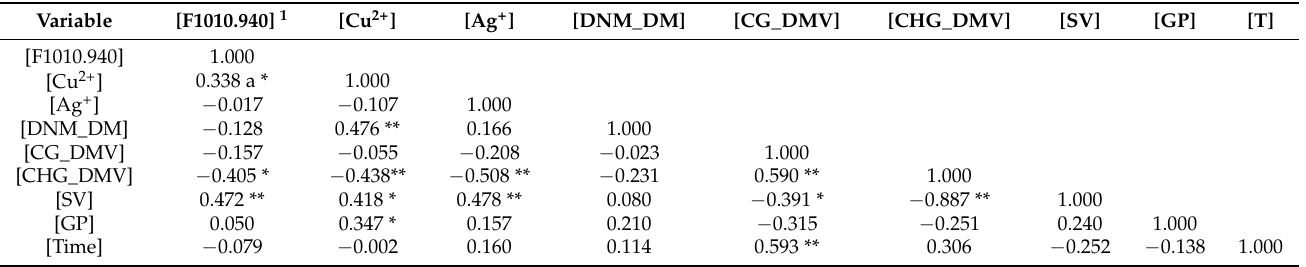
Table 2. Pearson’s linear correlation coefficients for analyzed